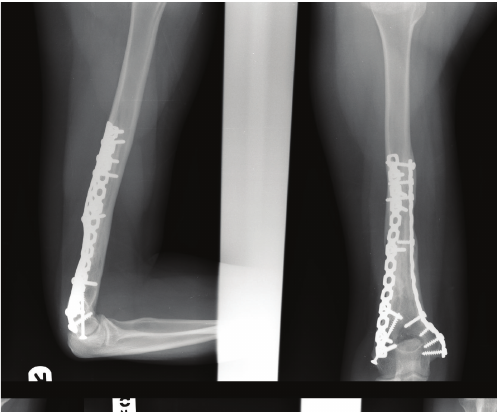
Figure 7: Lateral and anteroposterior X-ray 10 years after surgery. These show full healing and consolidation of the graft with excellent union at both ends of the